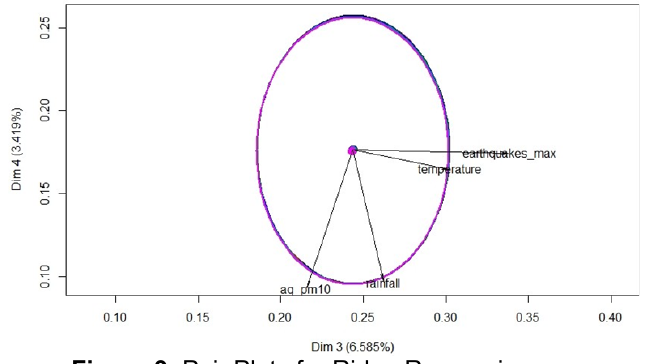
Figure 9. Pair Plots for Ridge